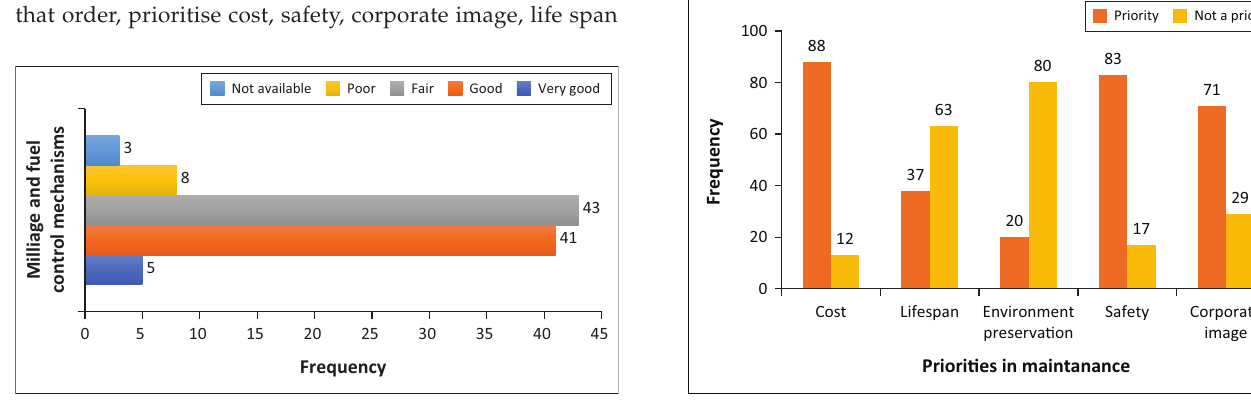
FIGURE 5: An evaluation of the fuel-mileage control system. FIGURE 6: Key consideration in vehicle